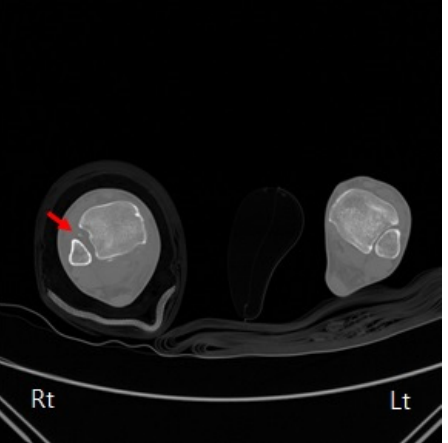
Figure 2. Preoperative axial computed tomography scan showing a syndesmotic injury in the right ankle. It can be seen that the fi bula is dislocated from the fi bula notch (red arrow).